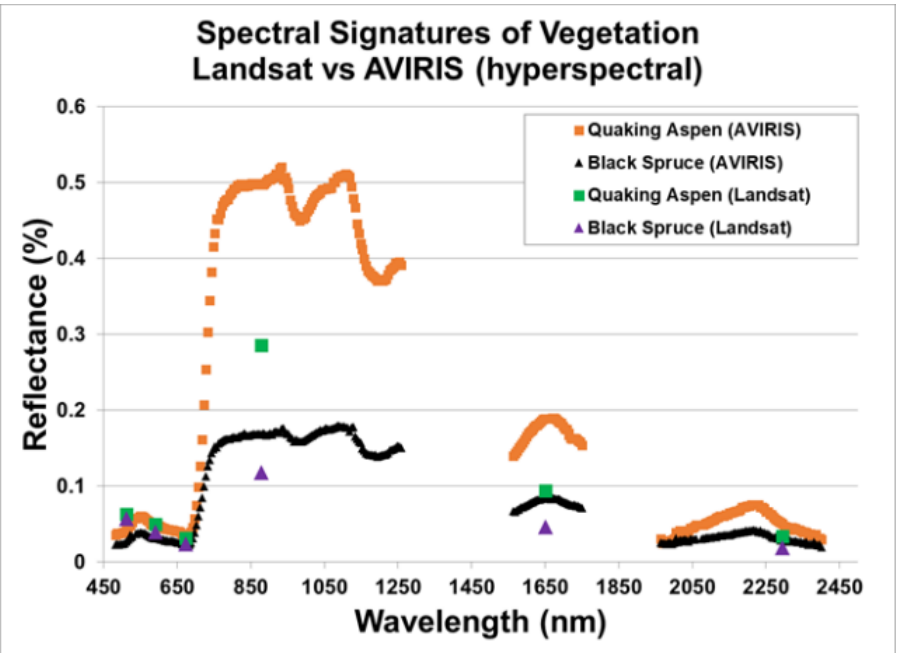
Figure 1. Comparison of spectral signatures of two distinct vegetation classes extracted from hyperspectral AVIRIS-NG and multispectral Landsat 8 data. The AVIRIS-NG spectral signature is more unique between different vegetation classes.